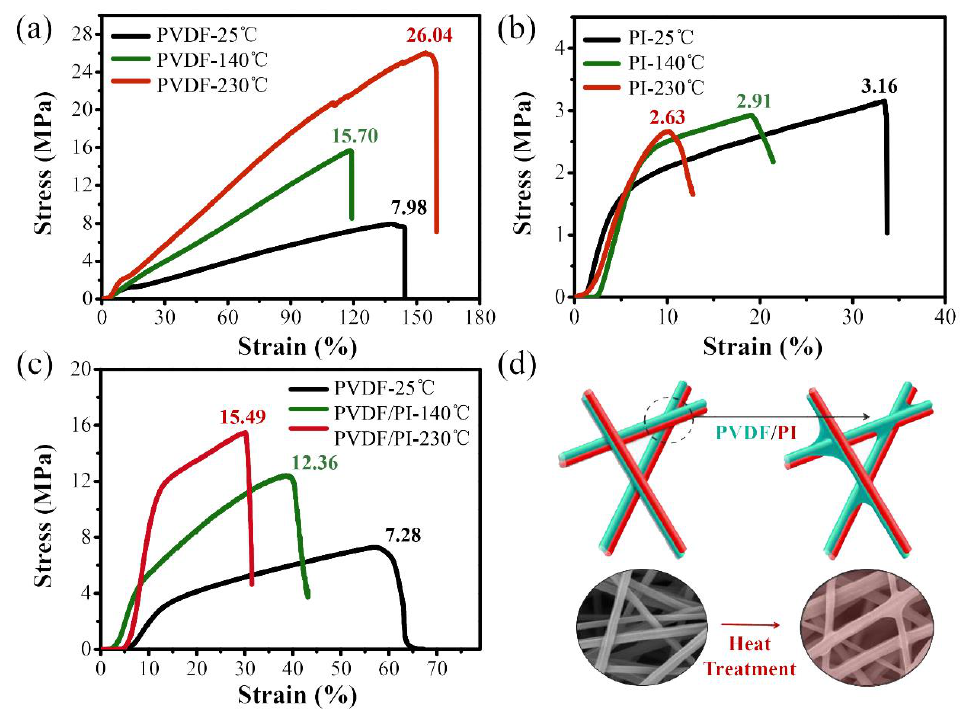
Figure 5. The stress–strain curves of PVDF ( a ), PI ( b ), and PVDF/PI ( c ) electrospun membranes before and after the heat treatment; Fibers heat treatment diagram ( d ).